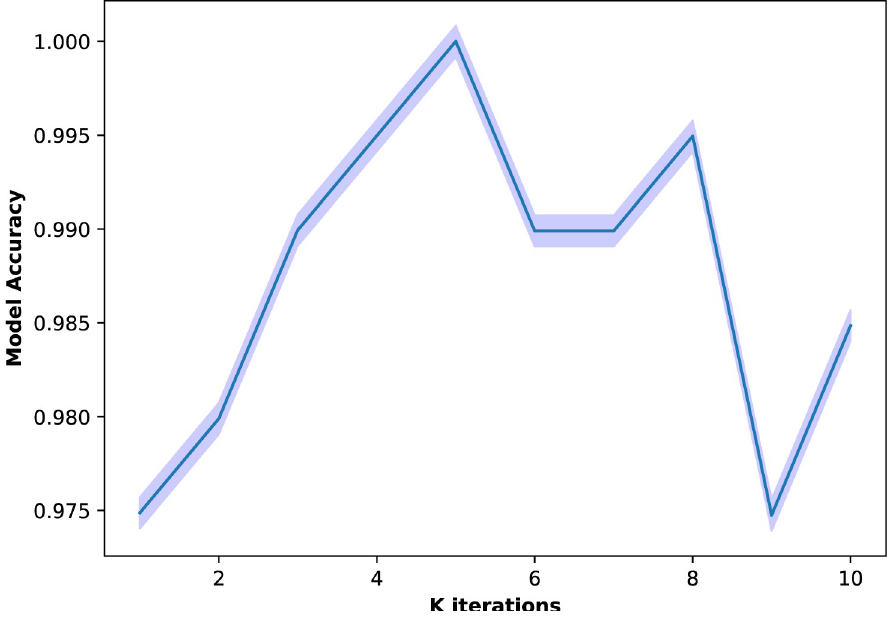
Fig 9. The proposed model’s accuracy with 95% confidence interval for 10 cross-validation